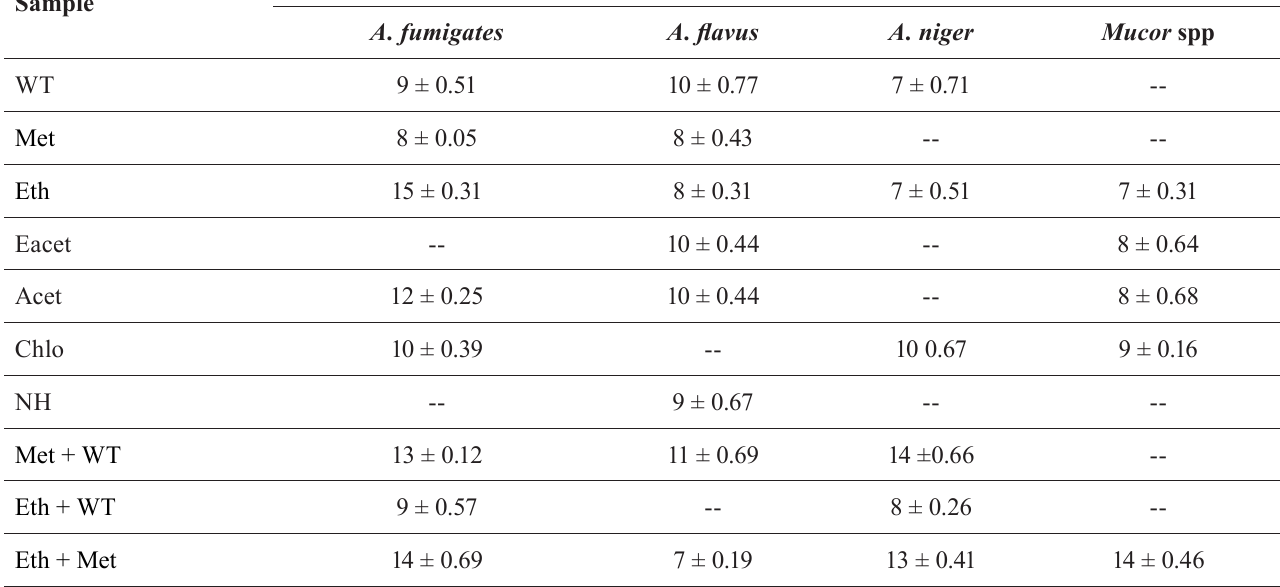
TABLE III - Antifungal activities of different solvents extracts of E. intermedia